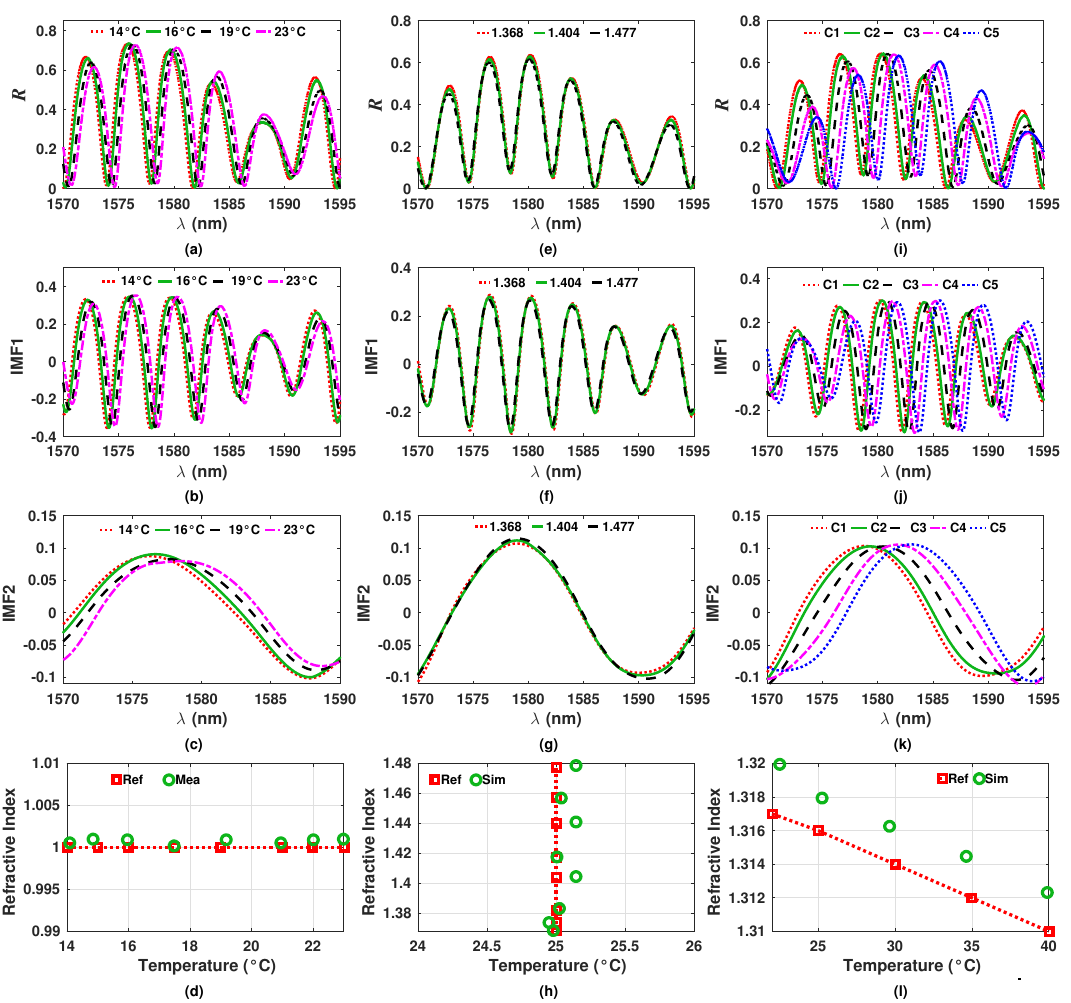
Figure 10. ( a ) Experimental R spectrum of the filter in air and at different temperatures and their corresponding ( b ) IMF1 and ( c ) IMF2 functions and ( d ) the estimated n 4 and T values; ( e ) Experimental R spectrum at T = 25 °C and different n 4 values and their corresponding ( f ) IMF1 and ( g ) IMF2 functions and ( h ) the estimated n 4 and T values; ( i ) Experimental R spectrum at different T and n 4 values and their corresponding ( j ) IMF1 and ( k ) IMF2 functions and ( l ) the estimated n 4 and T